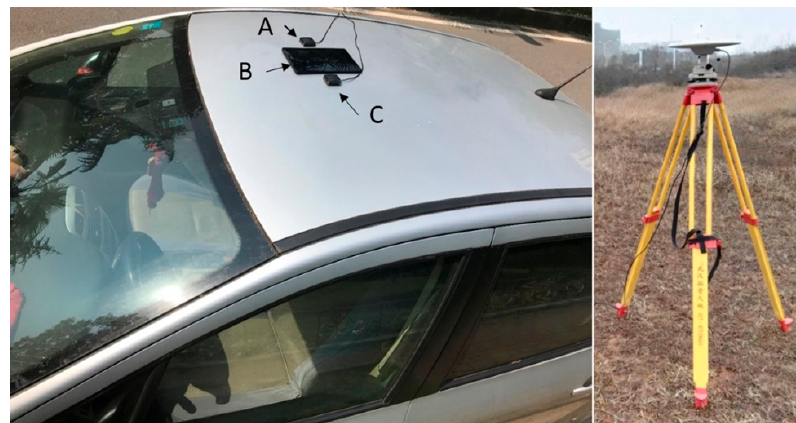
Figure 9. Illustration of the kinematic experiment configuration of the vehicle ( left ) and the reference station ( right ). Two patch antennas, i.e., A and C, and Nexus 9 tablet, i.e., B, were placed on the roof of a car. Remote Sens. 2019 , 11 , x FOR PEER REVIEW 17 of 21